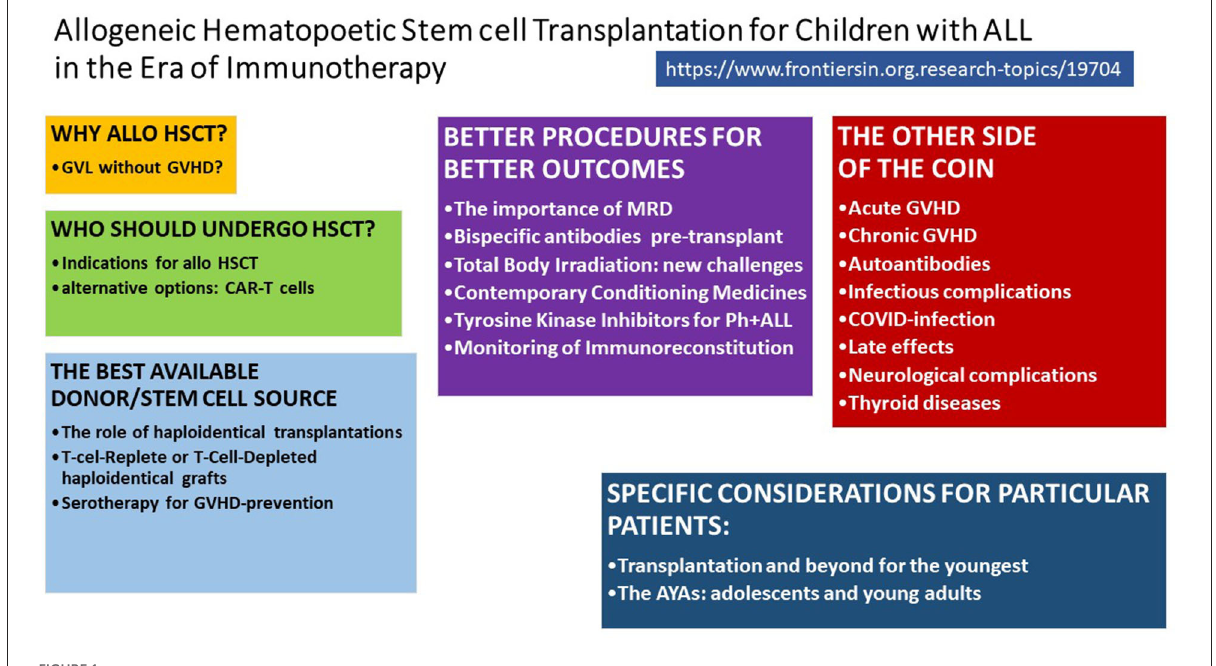
FIGURE1 Tools and challenges to cure high-risk